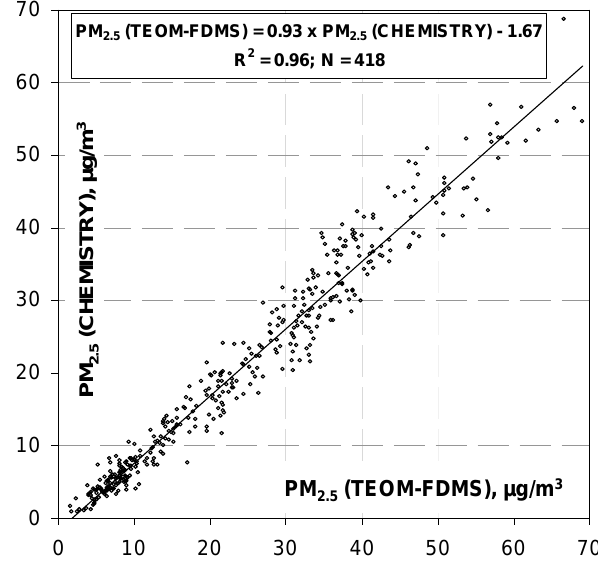
Fig. 3. Comparison between hourly PM 2 . 5 concentrations measure- ments performed by TEOM-FDMS and hourly PM 2 . 5 concentra- tions reconstructed from the chemical analyses by summing EC, POM, and